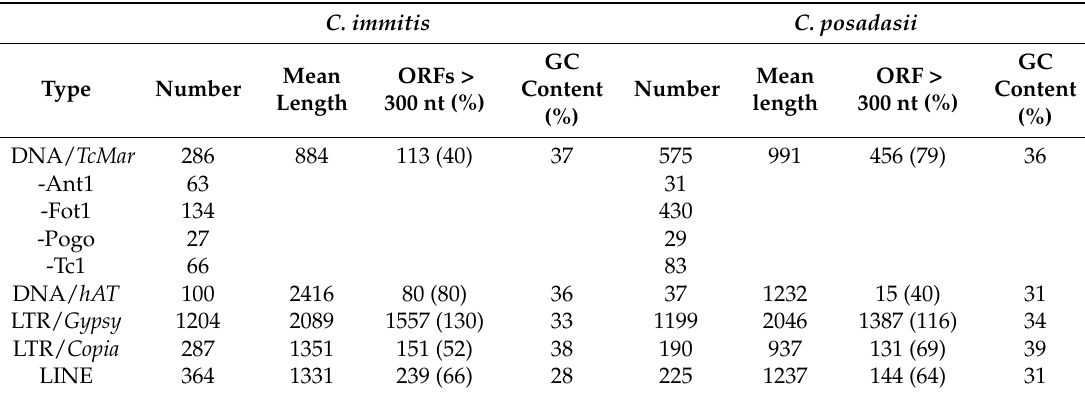
Table 1. Predicted TEs in Coccidioides spp.